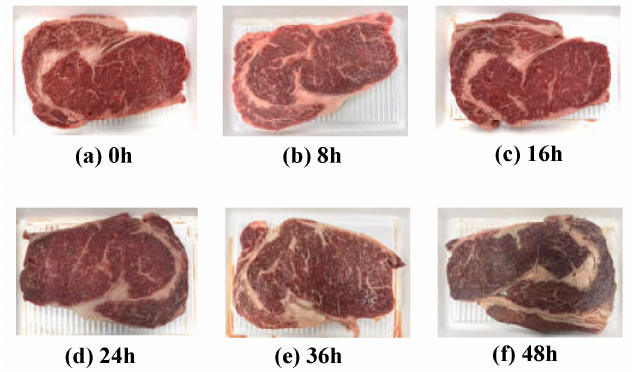
Figure 1. Images of beef loins over the elapsed storage